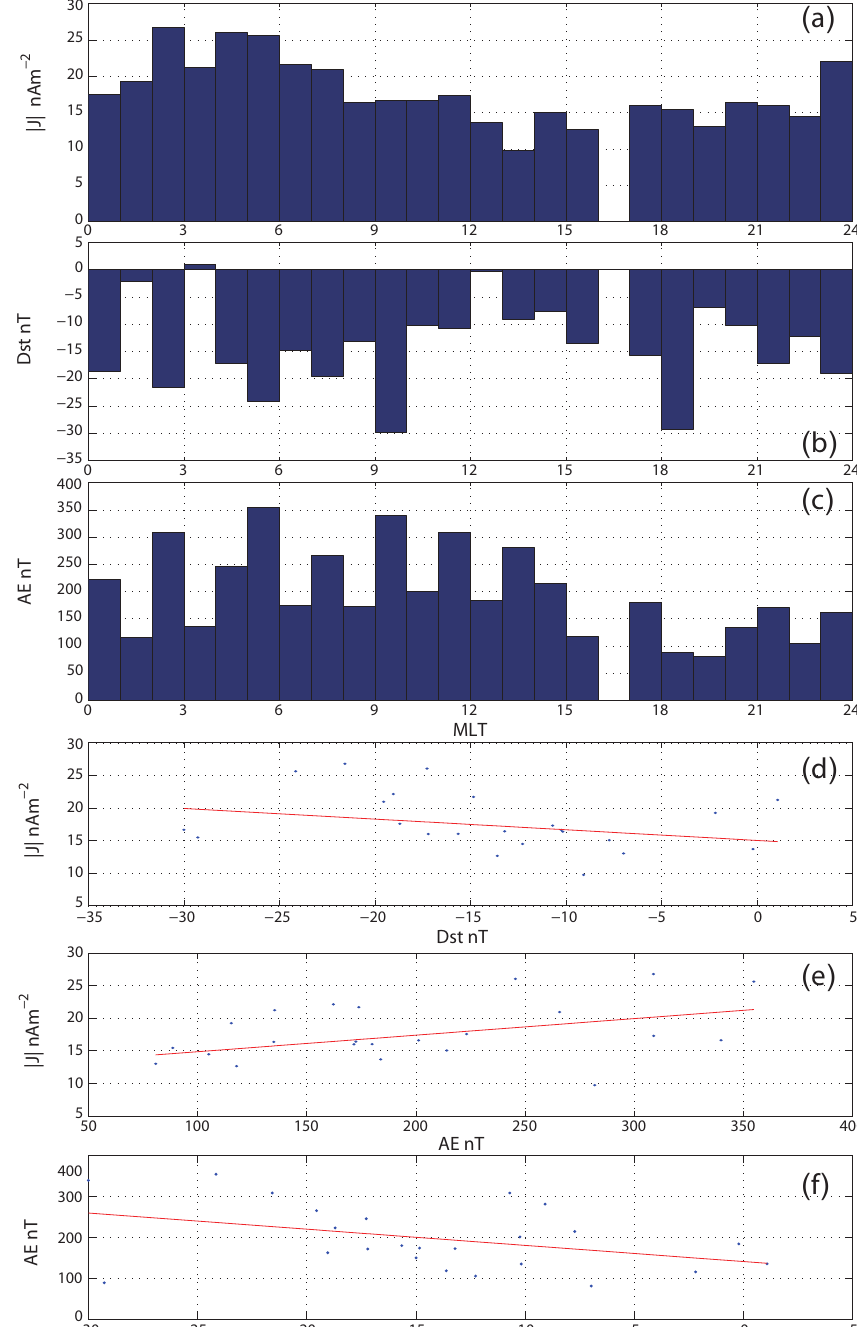
Fig. 5. The MLT distributions of the one hour average current density | J | (from Fig. 4) and the corresponding MLT distributions of the Dst and AE indices, respectively, together with the scatter plots of this average current density | J | against Dst and AE indices, and AE against Dst,